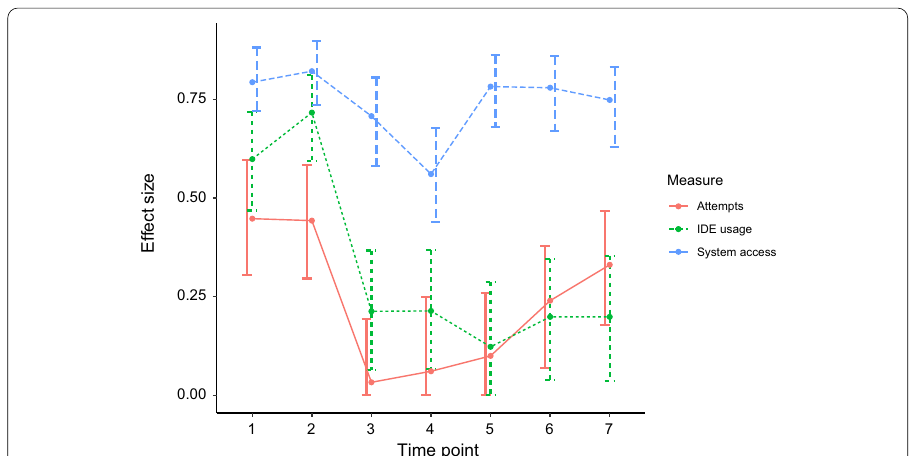
Fig. 3 Gamification’s effect (compared to no gamification) over time, based on effect sizes estimated from differences in behavioral outcomes. Error bars represent the 95% confidence intervals estimated from effect